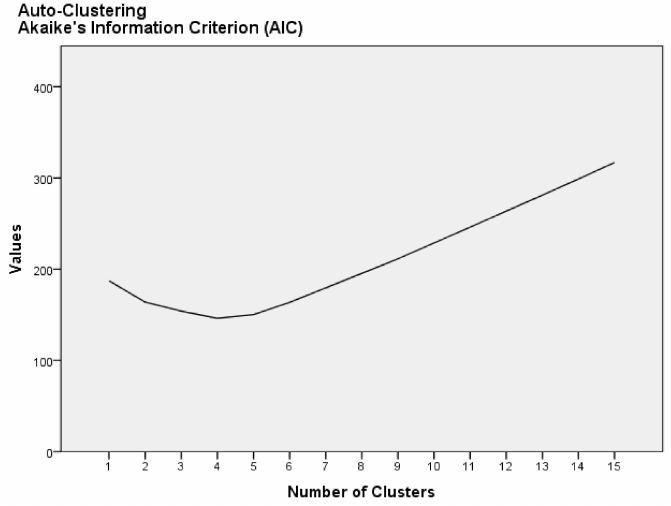
Figure 2. Akaike Information